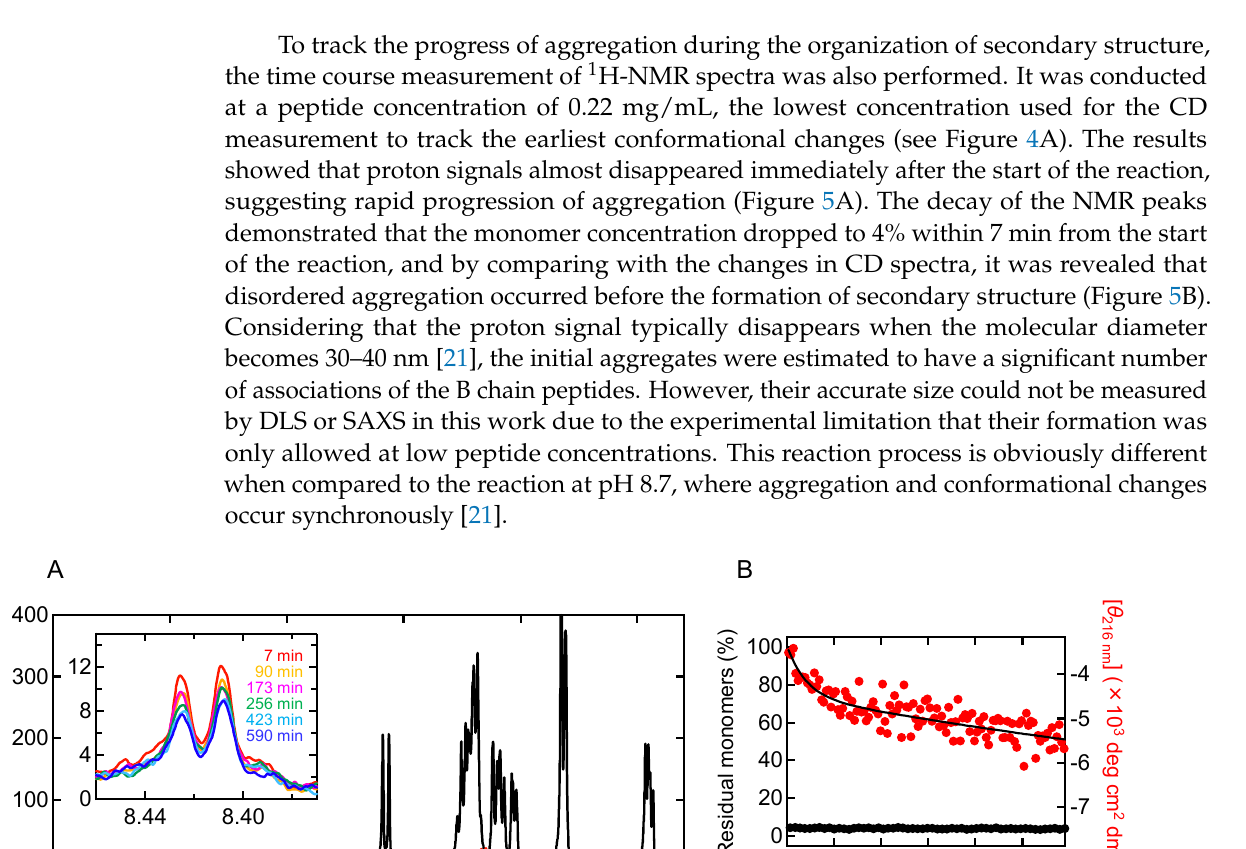
Figure 5. Quantification of residual monomers in the process of the formation of prefibrillar aggre- gates at pH 5.2 using 1 H-NMR spectra. ( A ) Time-dependent change in 1 H-NMR spectra in a low magnetic field region. The measurement was performed at a B chain concentration of 0.22 mg/mL. Inset shows a magnified view of peaks of two histidine ε protons, which were used for quantifying the fraction of residual monomers. The black line is the spectrum of a monomer state obtained with the B chain dissolved in a NaOH solution, and it should be noted that the peaks of two histidine ε protons are observed at around 7.6 ppm due to difference in pH. ( B ) Time course of the fraction of the residual monomers estimated from the area of the histidine peaks. For comparison, the time-dependent change in [ θ 216 nm ] at 0.22 mg/mL shown in Figure 4A is overlaid.